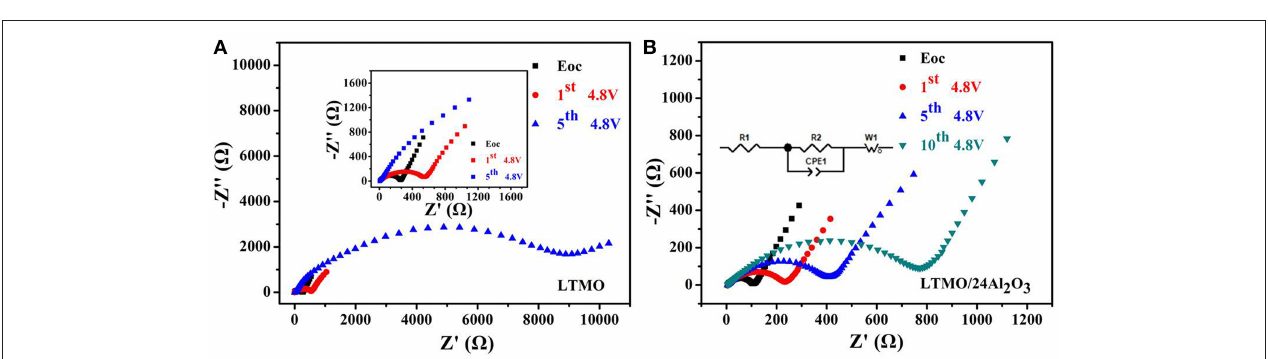
FIGURE 7 | EIS profiles of (A) LTMO and (B) LTMO/24Al 2 O 3 at the charge state of 4.8V in the different cycles; inset: an equivalent-circuit simulation